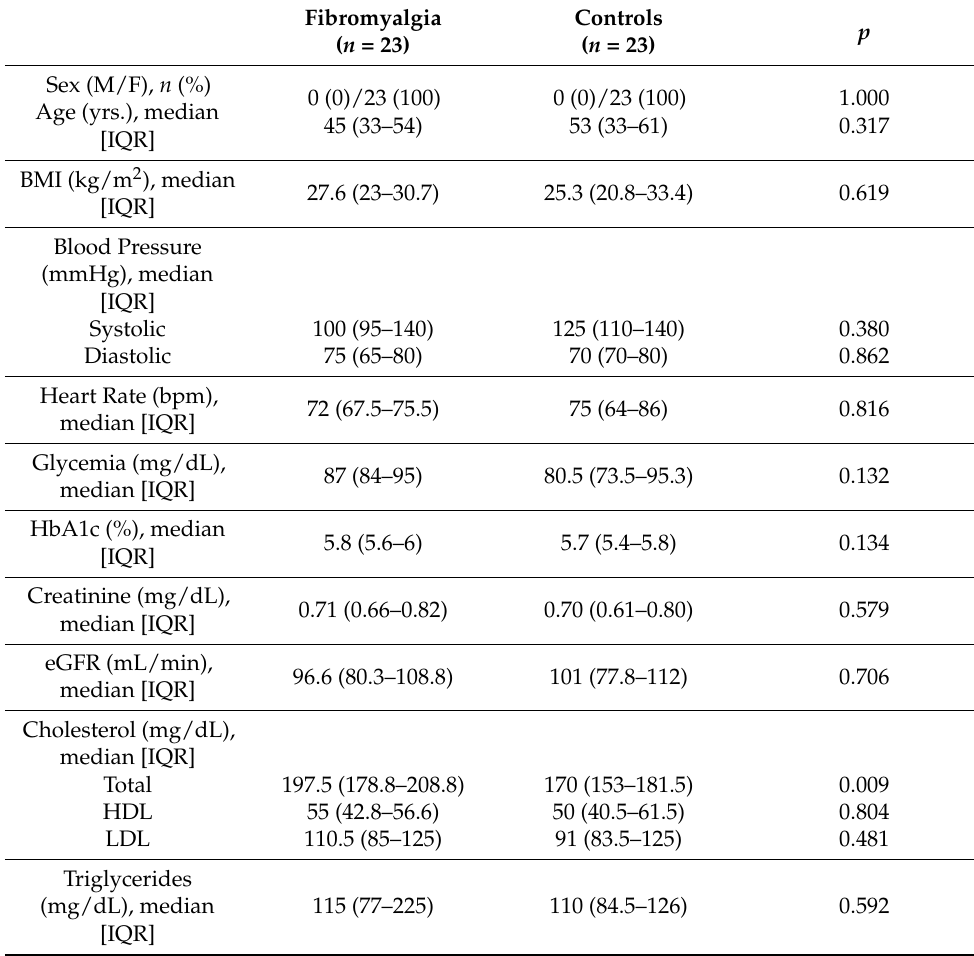
Table 1. General characteristics of the study population ( n =